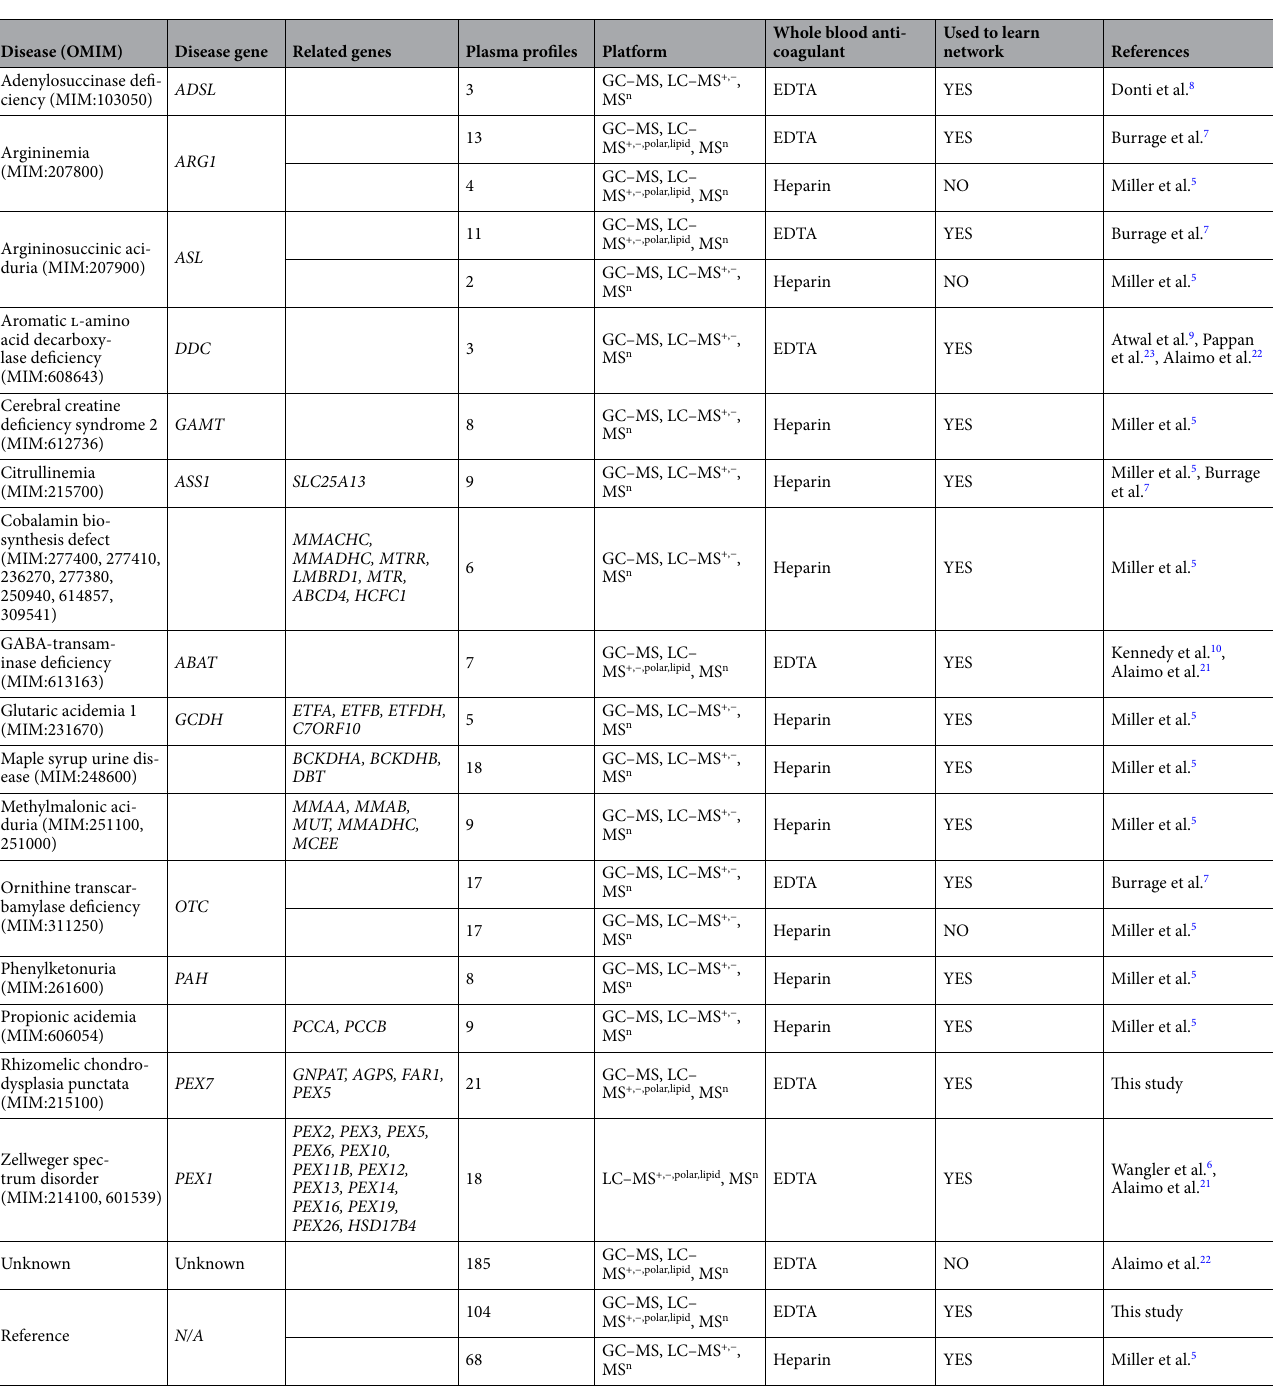
Table 1. Description of data and data sources. For each disease cohort, the number of samples and the publication source of the data are described. Individuals in the Unknown cohort 22 , a cohort whose clinical diagnoses from which we were blinded, may also have diagnoses associated with any of the disease cohorts listed. When samples in the Unknown cohort were identical to samples associated with a known clinical diagnosis, Alaimo et al. 22 is also referenced. For samples from Miller et al. 5 , genetic sequencing data was not available and thus, only biochemical diagnoses were made. As a result, when more than one gene is responsible for a given diagnosis, all known genes associated with the given diagnosis are listed in the Related Genes column. GC–MS gas chromatography–mass spectrometry, LC–MS liquid chromatography–mass spectrometry, MS n multi-stage mass